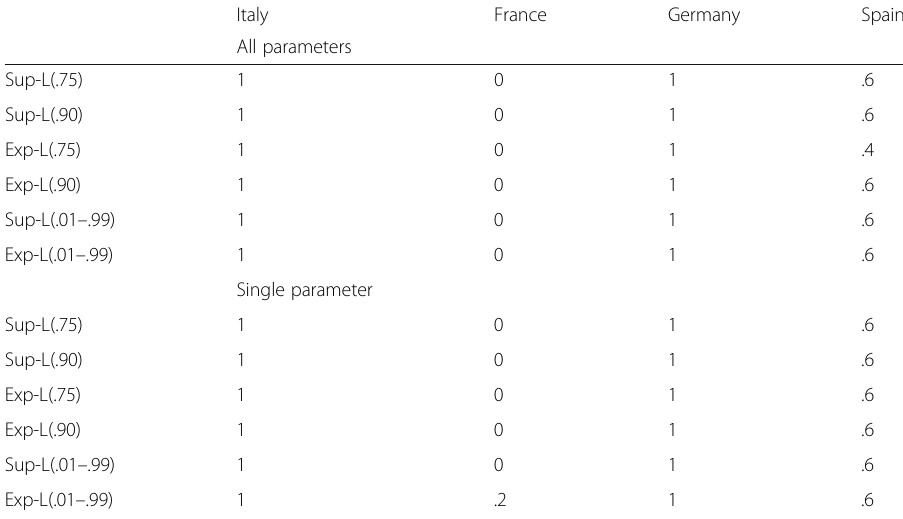
Table 1 End of sample instability test (Eq.